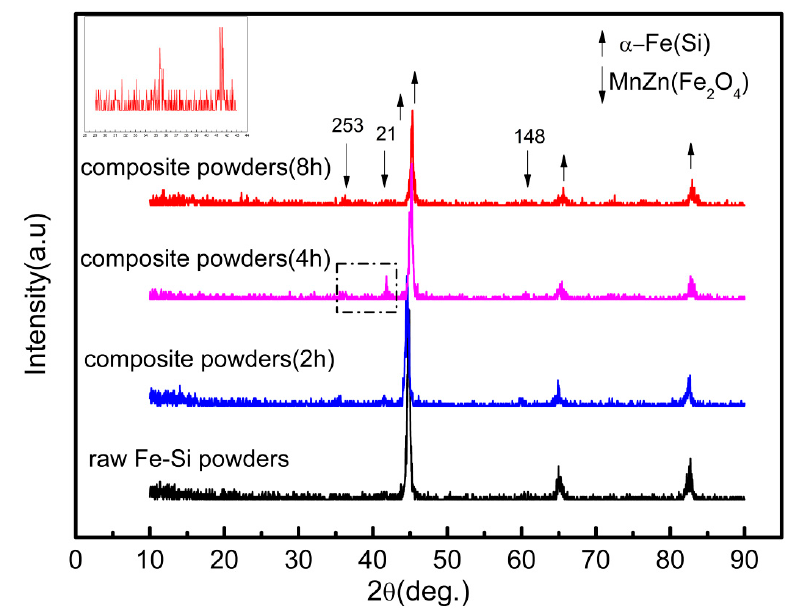
Figure 5. XRD patterns of raw Fe-Si powder and composite powders processed for different milling time (2 h, 4 h, 8 h, respectively).